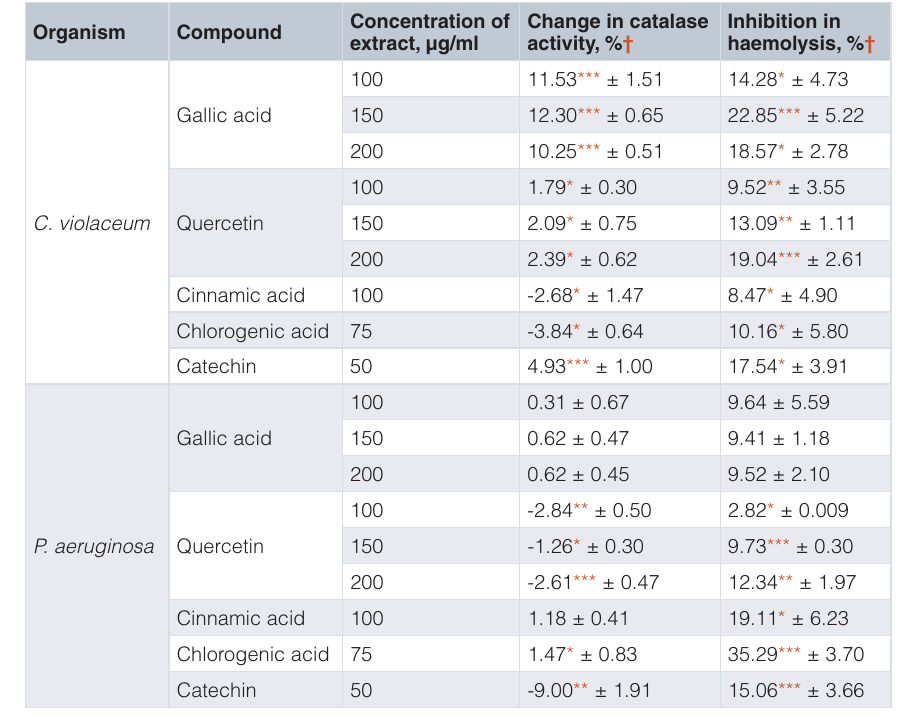
Table 3. Effect of pure compounds on catalase and haemolytic activity of test